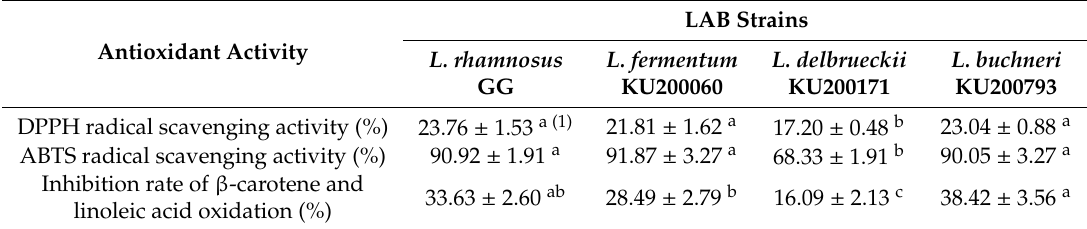
Table 4. Antioxidant activities of the Lactobacillus